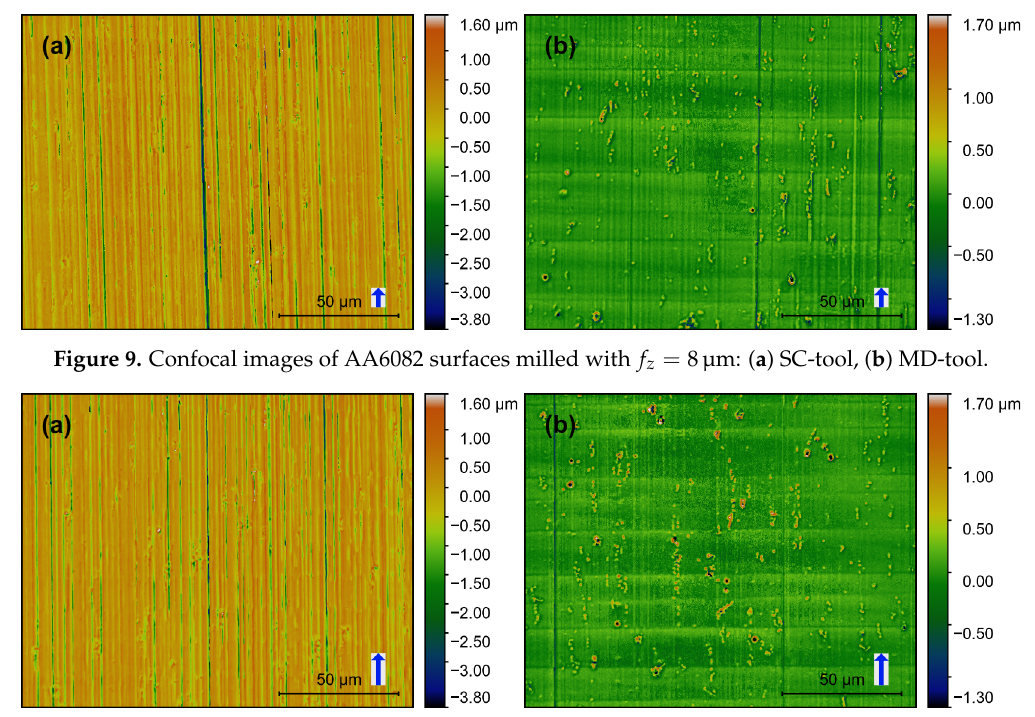
Figure 10. Confocal images of AA6082 surfaces milled with f z = 14µm:( a ) SC-tool, ( b ) MD-tool. Vertical roughness is mainly defined by f z which should be visible in the form of lines perpendicular to the milling direction. Horizontal roughness is mainly ruled by the mill’s cutting edge roughness.